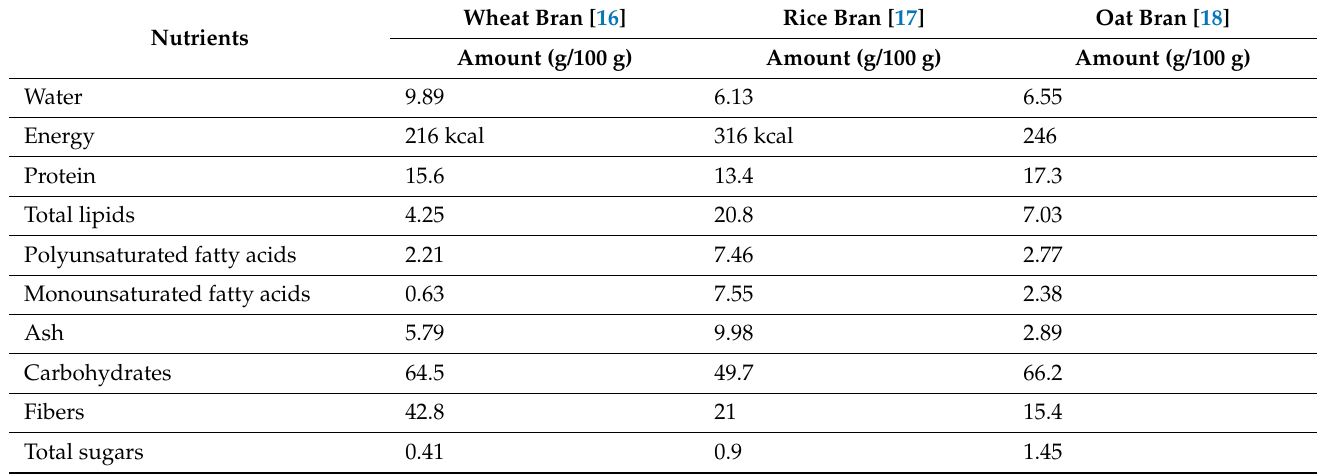
Table 1. Cereal bran nutritional composition .